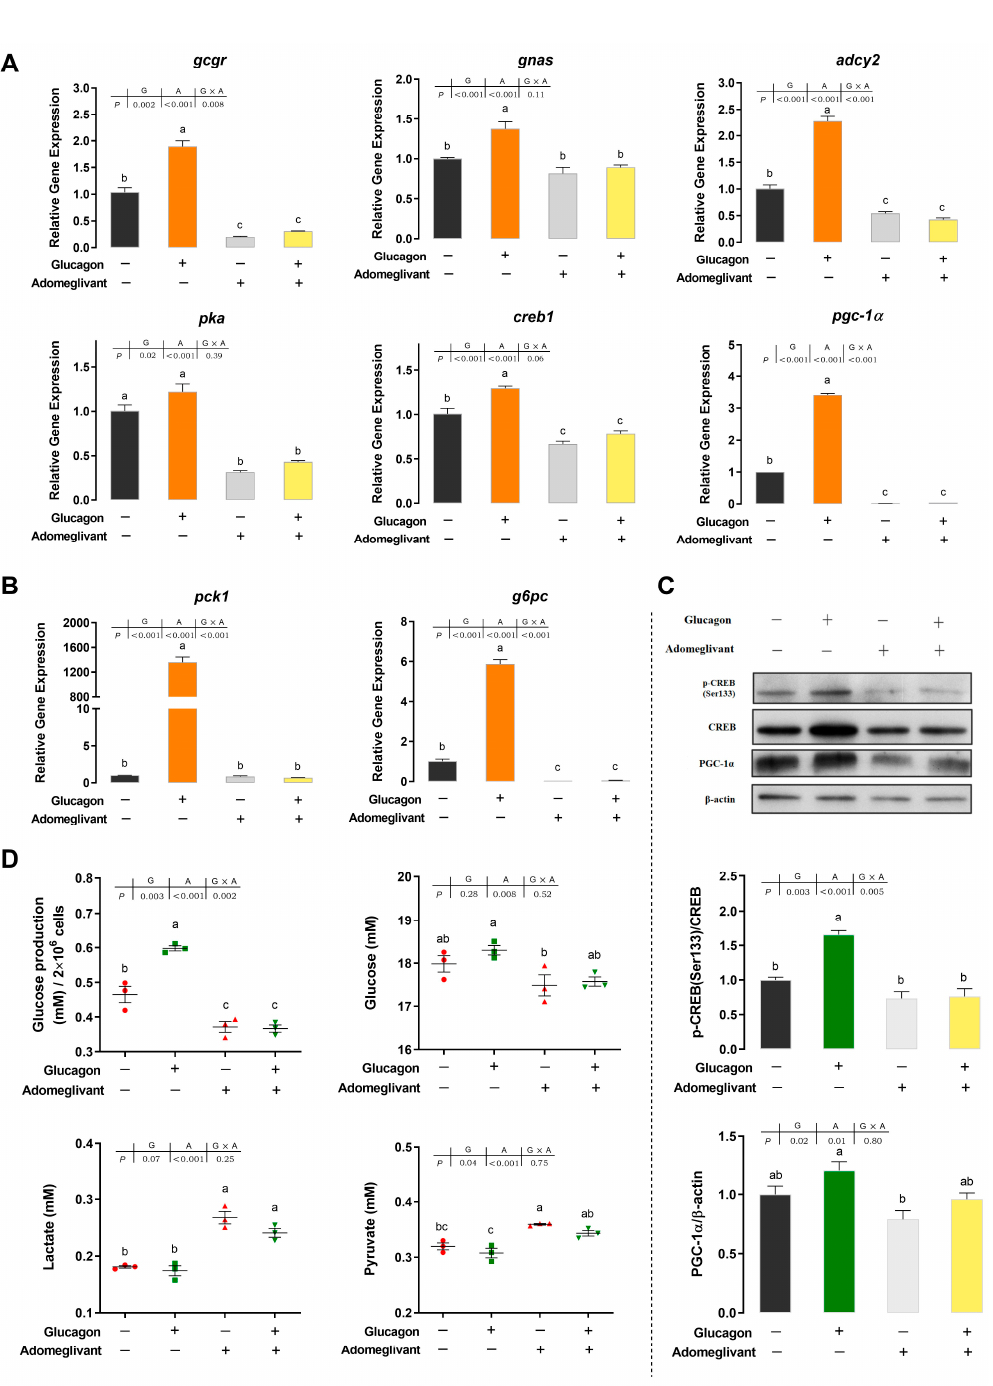
Figure 4. Adomeglivant inhibits the glucagon pathway in hepatocytes by targeting GCGR. ( A ), qPCR analysis of the mRNA levels of glucagon pathway-related genes ( gcgr ; gnas ; adcy2 ; pka ; creb1 ; pgc-1 α ) following glucagon stimulation and treatment with adomeglivant (50 µM) in hepatocytes. ( B ), qPCR analysis of the mRNA levels of gluconeogenic genes ( pck1 and g6pc ) following glucagon stimulation and treatment with adomeglivant (50 µM) in hepatocytes. ( C ), Western blot analysis of p-CREB (Ser 133 ) and PGC-1 α following glucagon stimulation and treatment with adomeglivant (50 µ M) in hepatocytes. ( D ), Glucose production in hepatocytes, glucose, lactate, and pyruvate concentrations in the medium following glucagon stimulation and treatment with adomeglivant (50 µM). All data are expressed as mean ± SE, n = 3, two-way ANOVA with Tukey post-hoc test. Val- ues with di ff erent le tt ers mean statistical di ff erences ( p < 0.05). G: glucagon treatments; A: adomeglivant treatments; G × A: interaction between glucagon and adomeglivant treatments.